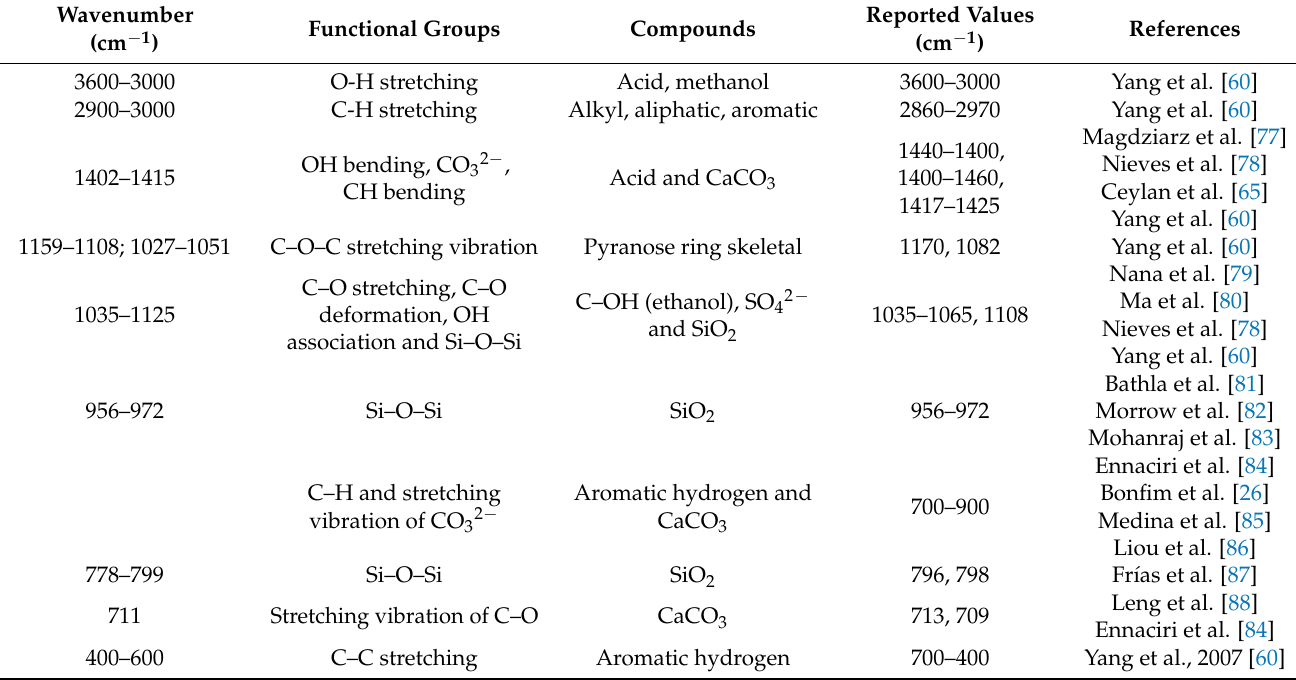
Table 3. The main functional groups of the three main components of the biomass fuels and the ashes produced at 600 ◦ C during combustion characterized by